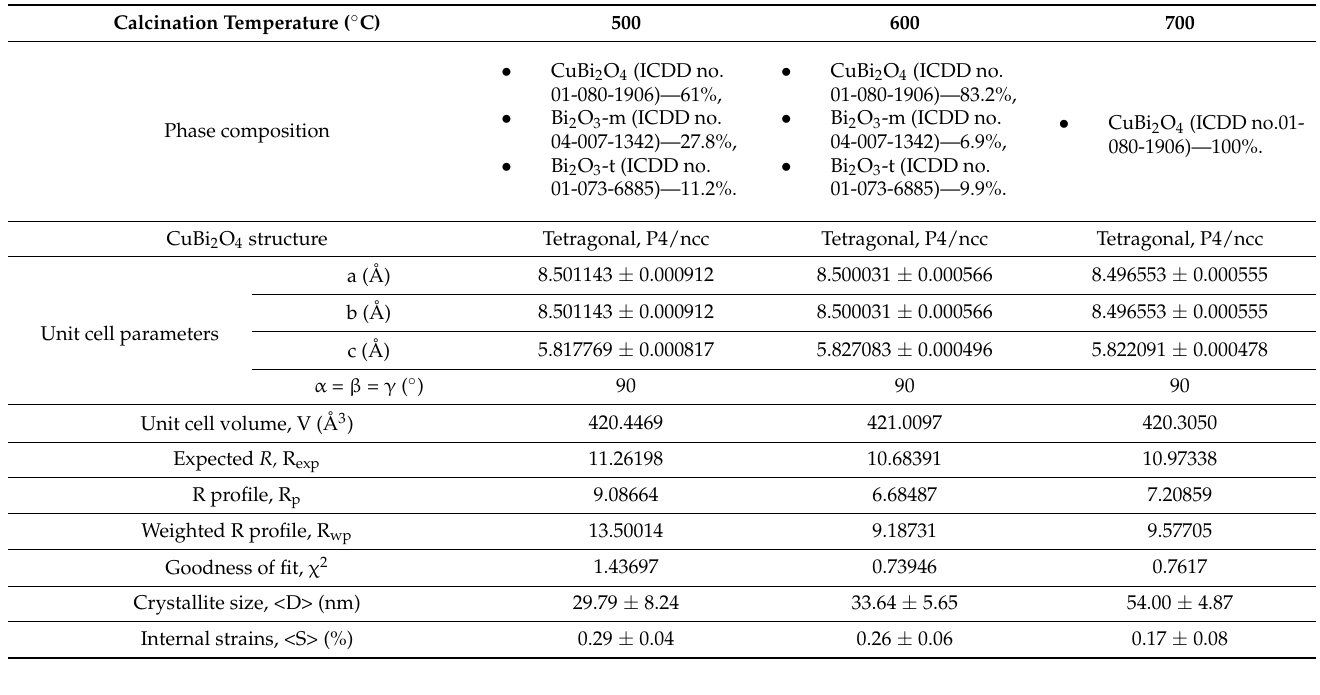
Table 1. Phase composition and structural parameters of CuBi 2 O 4 powders prepared by the oxalate route and thermally treated for 1 h at various temperatures.